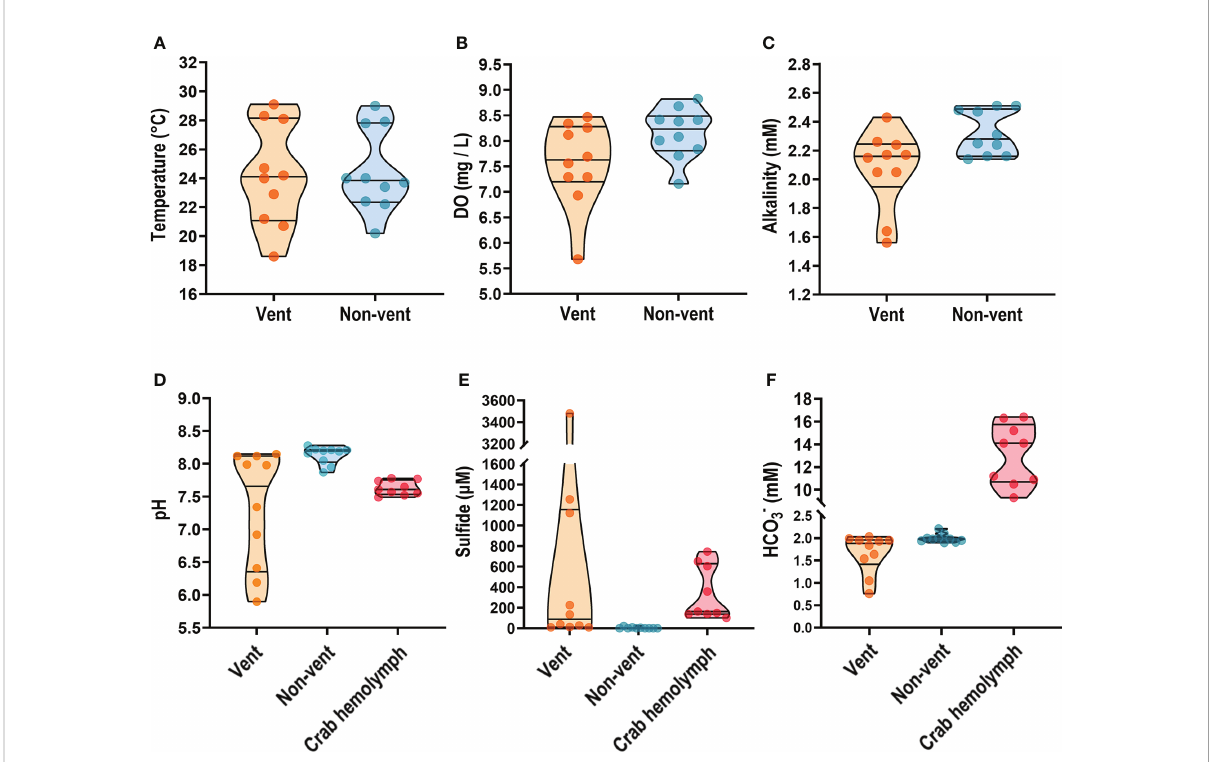
FIGURE 2 On-site measurement of physicochemical parameters from seawater and vent crab hemolymph. Temperature, dissolved oxygen (DO), and alkalinity of seawater samples collected from the vent and non-vent areas (A – C) were examined. The pH value, sul fi de and HCO 3 - concentrations were estimated both in seawater and crab hemolymph samples (D – F) . Parameters are presented as truncated violin plots with individual values also